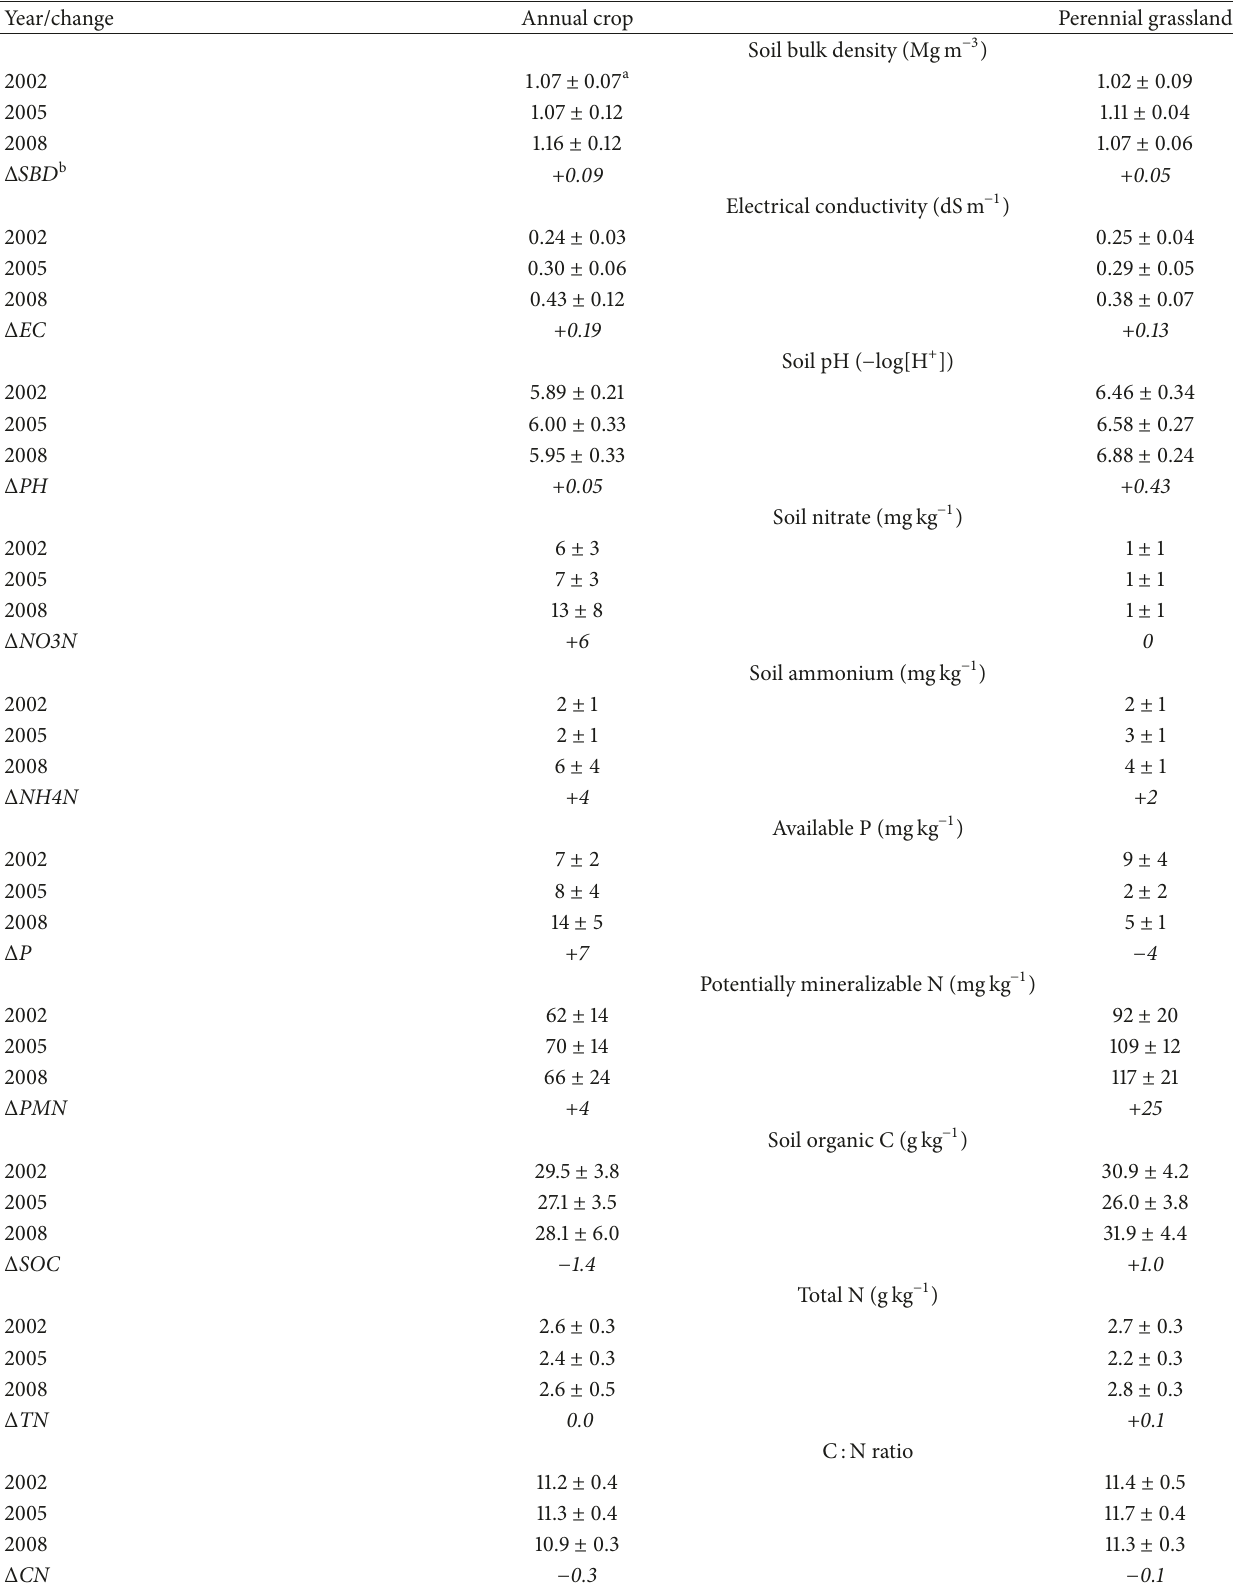
Table 4: Mean values of near-surface soil properties within annually cropped and perennial grassland integrated crop-livestock systems